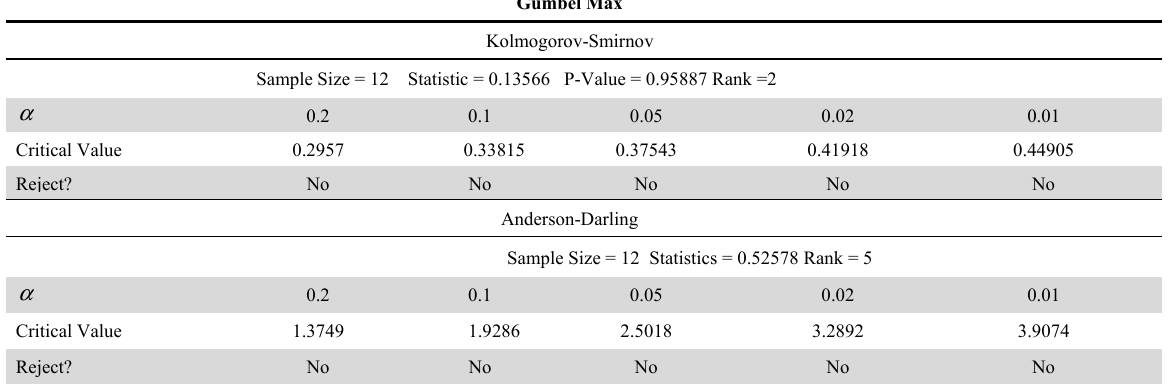
Gumbel Max Kolmogorov-Smirnov